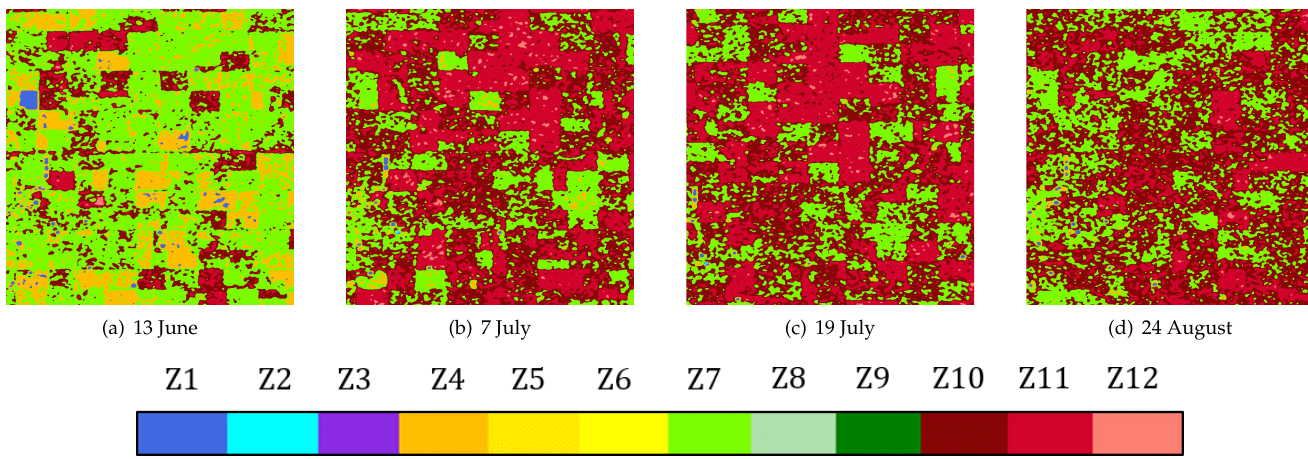
Figure 11. Images of temporal variation of clusters on H xP / θ xP plane over the study area. The dates are ( a ) 13 June; ( b ) 7 July; ( c ) 19 July and ( d ) 24